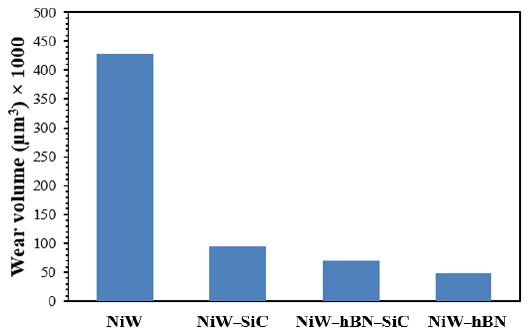
Figure 11. Wear volume for the respective DC electrodeposited coatings of NiW, NiW–SiC, NiW– hBN, and NiW–hBN–SiC